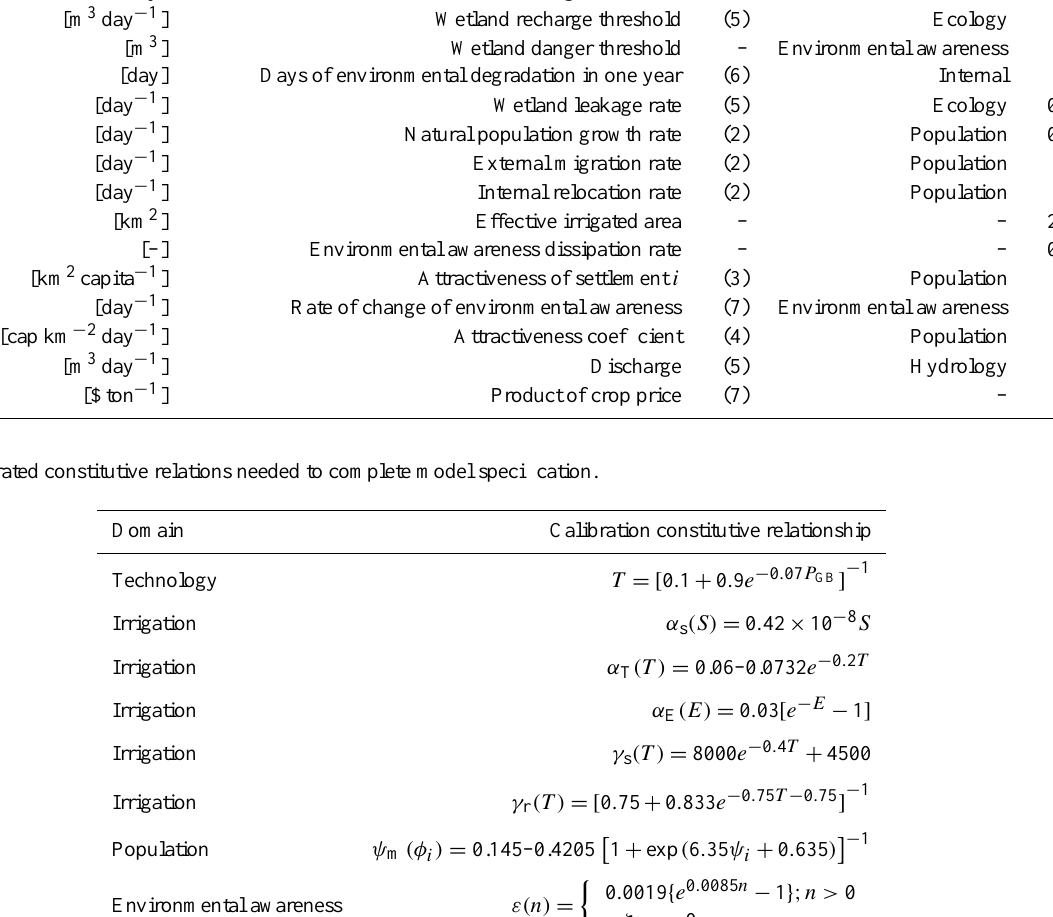
Table 2. Definitions of the parameters of the coupled human–water system model and the chosen magnitudes of the parameter values. Variables